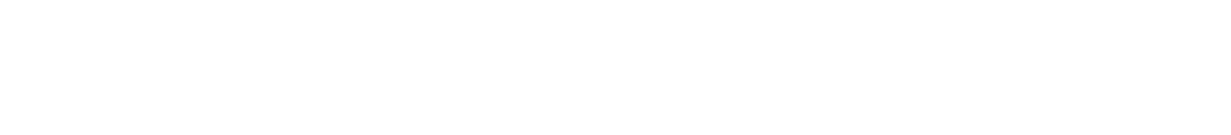
Frontiers in Molecular Biosciences |